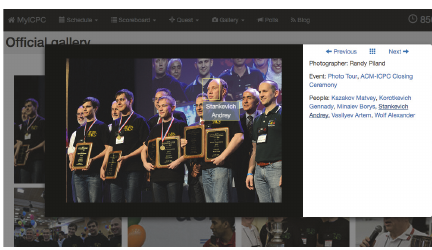
Figure 9: Media gallery with metadata.